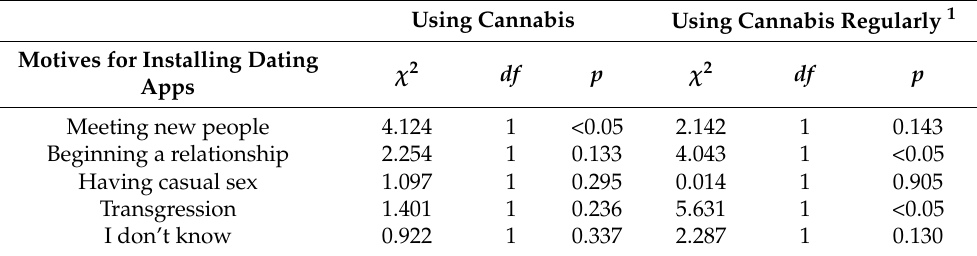
Table 5. Results from chi-squared analysis investigating the association between different levels of using cannabis and app installation motives in the sample of active users. Note that when the Bonferroni correction is applied, the significance level is set at 0.01. Using Cannabis Using Cannabis Regularly